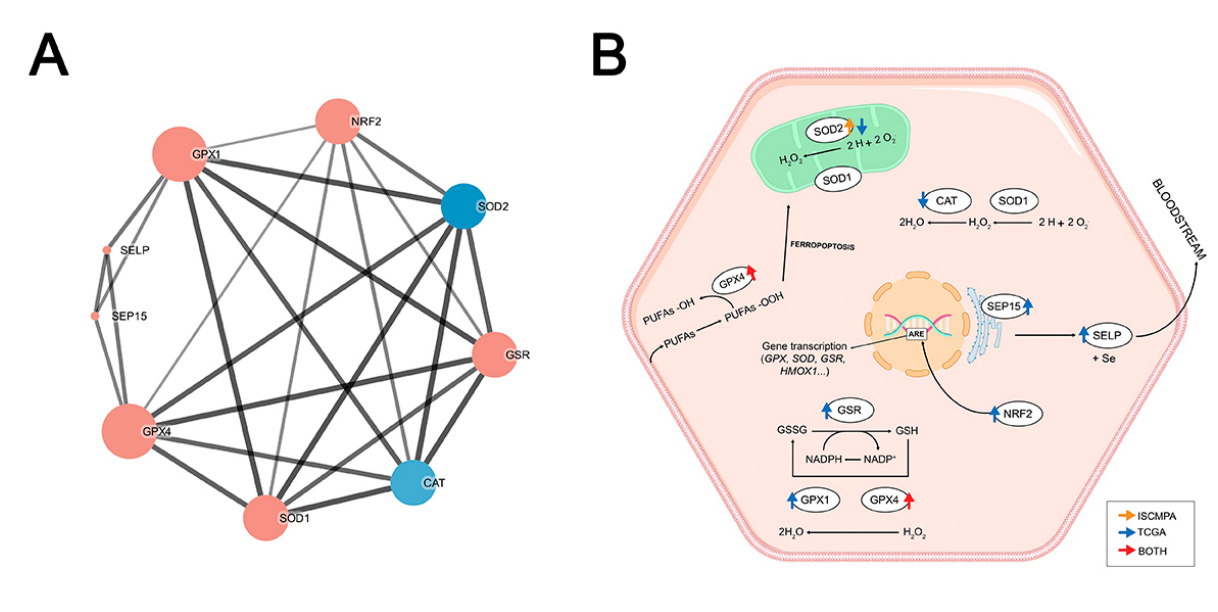
Figure 4 – Enriched annotation pathways and interaction network analysis of antioxidant proteins investigated in the present study. (A) Protein-protein interaction network of the analyzed genes. Lines represent interaction associations between nodes and line thickness indicates the strength of data support (score). Size of nodes indicates the degree of associations. Blue nodes represent downregulated genes and red nodes represent upregulated genes according to data from case (TCGA) vs control (GTEx) analyses. (B) Illustrative representation of antioxidant enzymes functions in hepatocytes. Up- and down- arrows denote significant upregulated or downregulated genes, respectively. Red arrows: both analysis; Blue arrows: only in TCGA analysis; Orange arrows: only in experimental analysis. Abbreviations: GPX1, glutathione peroxidase 1; GPX4, glutathione peroxidase 4; GSR, glutathione reductase; SOD1, superoxide dismutase 1; SOD2, superoxide dismutase 2; CAT, catalase; SEP15, 15 KDa selenoprotein; SelP, selenoprotein P; GSSG, oxidized glutathione; GSH, reduced glutathione; NRF2; nuclear factor erythroid 2-related factor 2; HMXO1; heme oxygenase-1 gene; ARE; antioxidant response element; Se, selenium; and PUFAs; Polyunsaturated fatty acids.